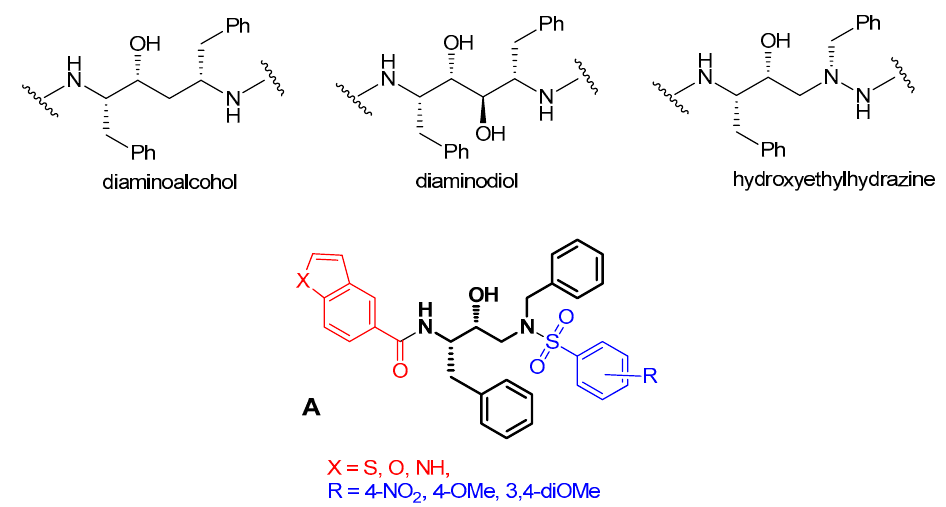
Figure 2. Examples of pseudo-symmetrical core of HIV-protease inhibitors.